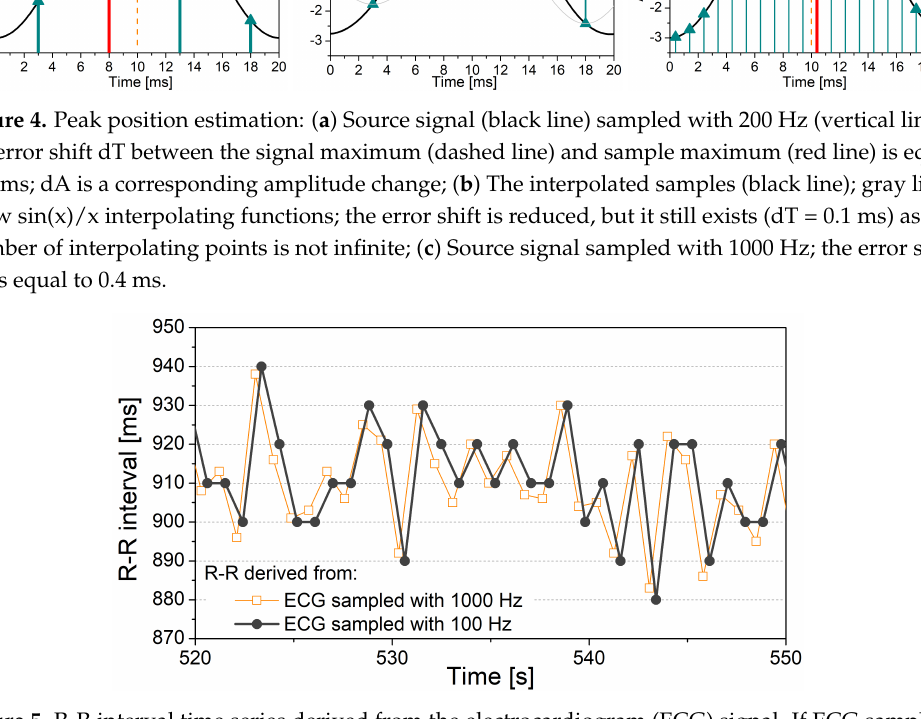
Figure 5. R-R interval time series derived from the electrocardiogram (ECG) signal. If ECG sampling frequency is equal to 100 Hz, the number of different R-R values is only seven (marked by horizontal lines). The ECG signal was acquired by TaskForce monitor